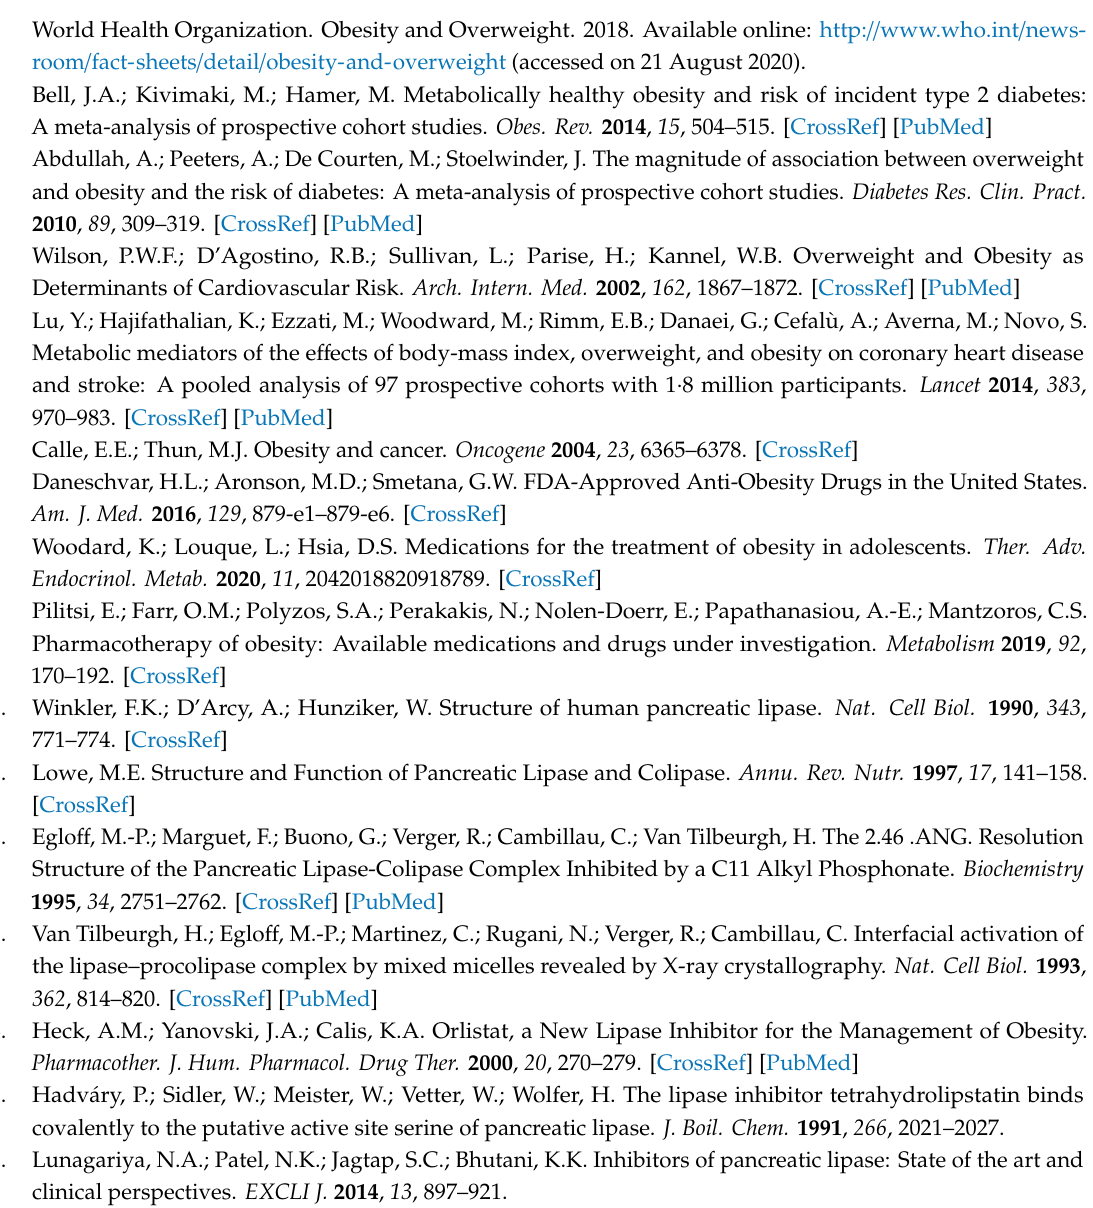
Supplementary Materials: The following are available online. Table S1. Docking results of 82 aurone compounds with